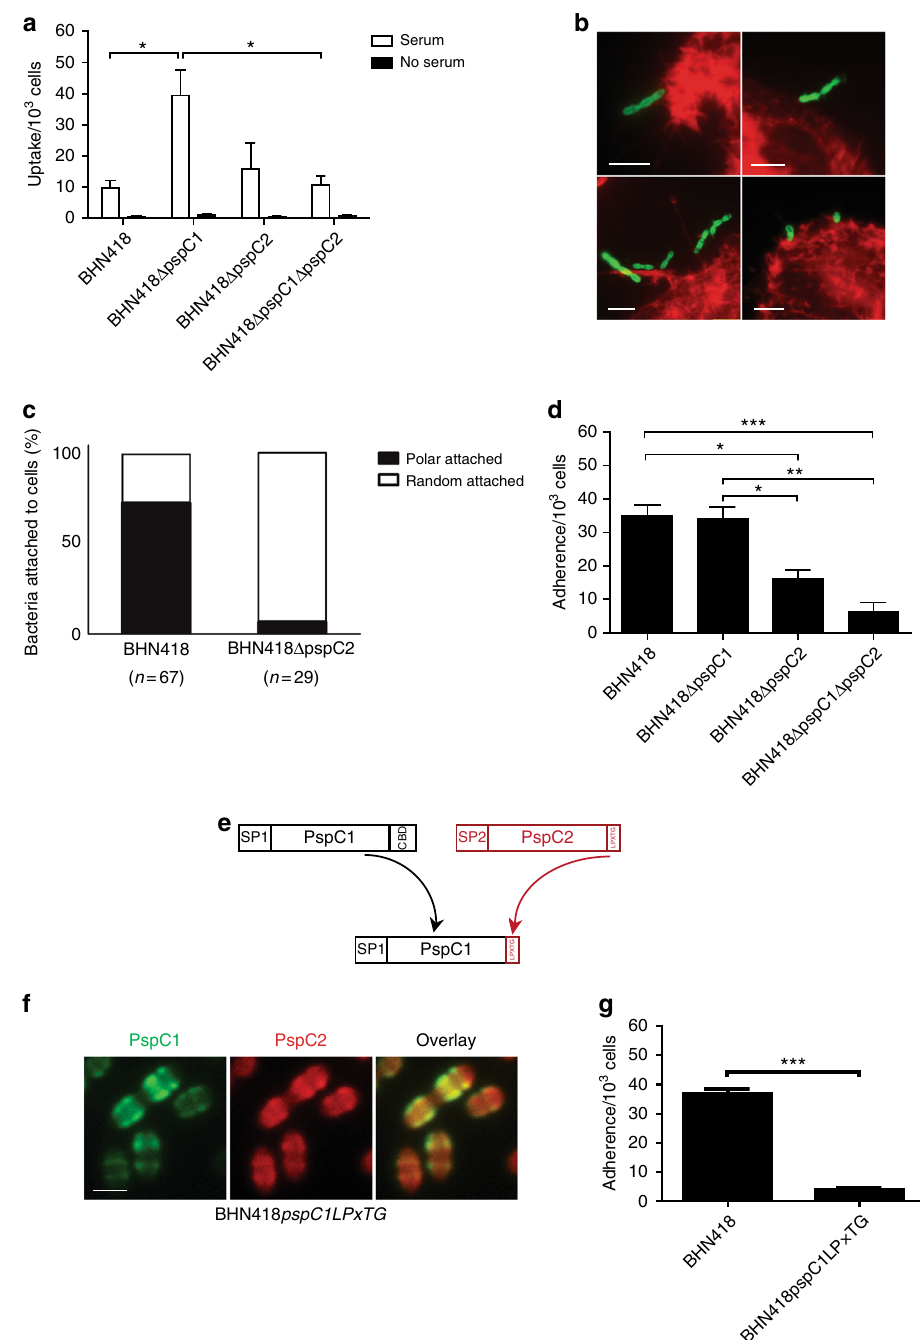
Fig. 6 PspC1 at division sites protects encapsulated pneumococci from opsonophagocytosis while PspC2 at the pole mediates cell adhesion. a Uptake of strain BHN418 or its isogenic pspC deletion mutants, with or without human serum, by THP-1 derived macrophages. Graph shows Mean ± SEM of three independent experiments *, p < 0.05. b Representative immuno fl uorescence images showing bacteria attached to A549 lung epithelial cells via the poles. Phalloidin stained A549 cells (red) were incubated with FITC stained BHN418 bacteria (green). Scale bar = 5 µ m. c Quantitative analysis of bacterial adhesion to A549 lung epithelial cells. d Adherence of wild type BHN418, or its isogenic pspC deletion mutants, to human lung epithelial A549 cells. Graph shows mean ± SEM of four independent experiments. *, p < 0.05, **, p < 0.01, ***, p < 0.001. e Schematic presentation of the LPxTG anchoring domain mutant of PspC1. f Representative immuno fl uorescence images of localization of PspC1 and PspC2 on the BHN418 pspC1LpxTG mutant. Antibody labeled with Alexa fl uor 594 (red) was used in combination with mouse anti-PspC1 serum and FITC-labeled secondary antibody (green). Scale bar = 1 µ m. g Adherence of the BHN418 pspC1LPxTG mutant to human lung epithelial A549 cells. Graph shows mean ± SEM of three independent experiments. ***, p <